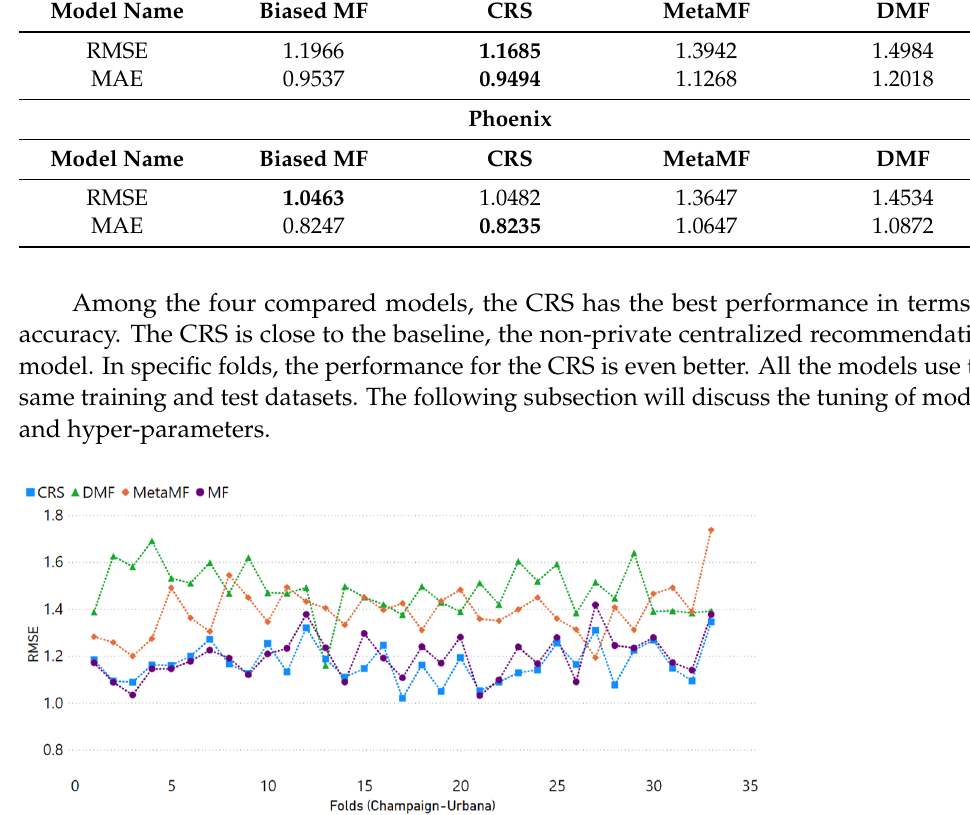
Figure 5. The RMSE comparisons among the four models for each training–test dataset pair (Champaign-Urbana). The dataset is partitioned chronologically. (Abscissa: value of RMSE; or- dinate: index of